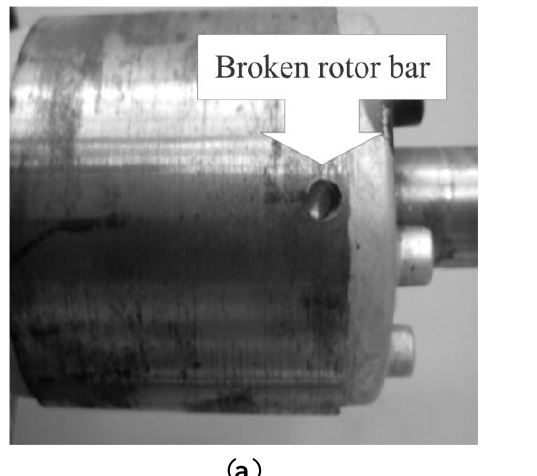
Figure 9. ( a ) Broken rotor bar; ( b ) Unbalance.